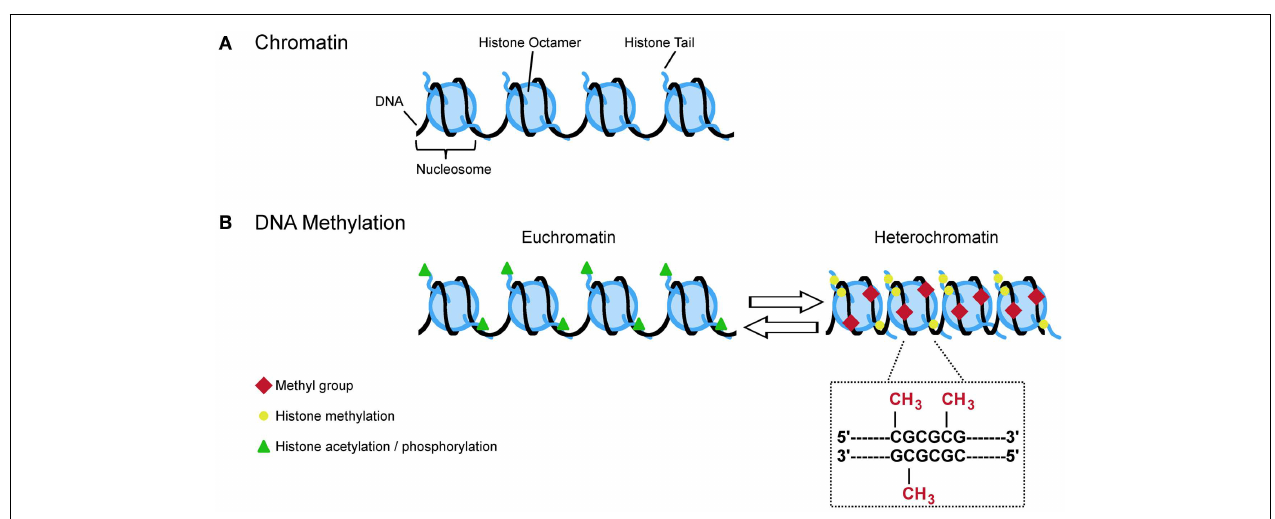
triangles) whereas methylation (yellow circles) is more often found at heterochromatin. Specific histone modifications and DNA methylation reciprocally influence each other in deposition. For example, histone methylation at H3K9, H3K27, and H4K20 promotes DNA methylation at CpG dinucleotides.This covalent modification refers to the transfer of methyl group to cytosine resides at gene regulatory regions. Hypermethylation typically links to lasting transcriptional repression while hypomethylation favors gene